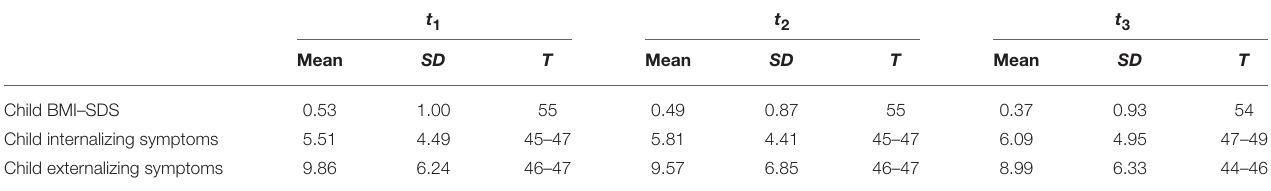
TABLE 2 | Descriptive statistics (means and standard deviations, T -scores) for BMI–SDS, internalizing, and externalizing symptoms ( t 1 , t 2 , t 3 ). t